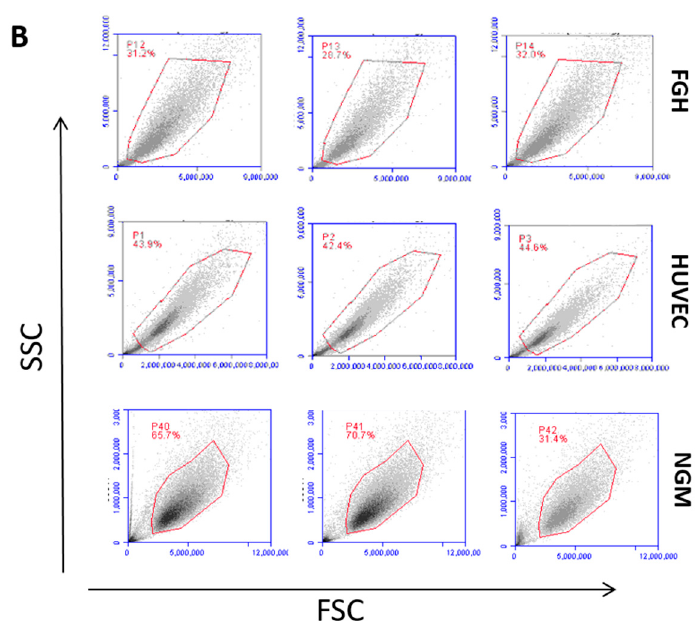
Figure 6. Effects of nanoparticles exposure in tumor. ( A ) MV3, MDA-MB-231, MCF-7, U373, PC-3, AGS, HT-29 and non-tumor ( B ) FGH, HUVEC, NGM cells.